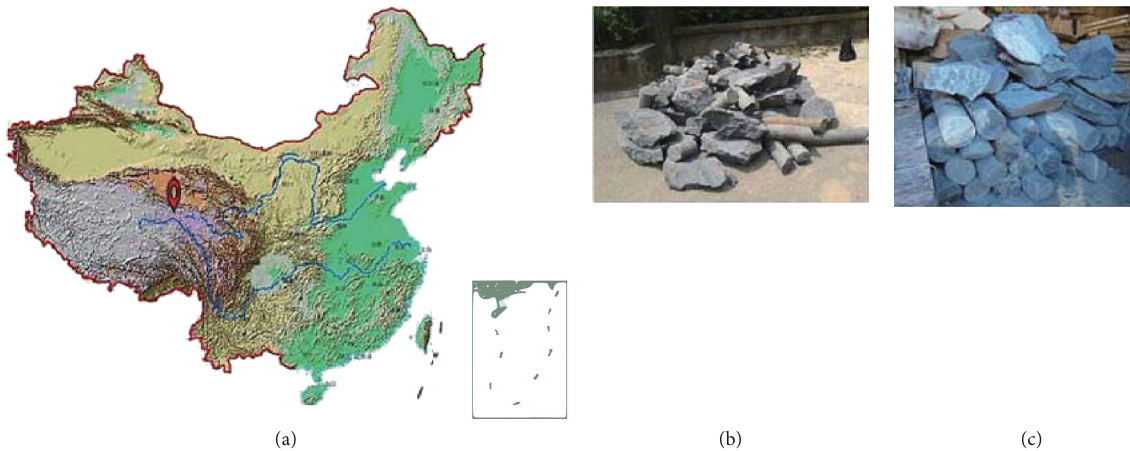
Figure 1: Rock sample acquisition site and sampling.